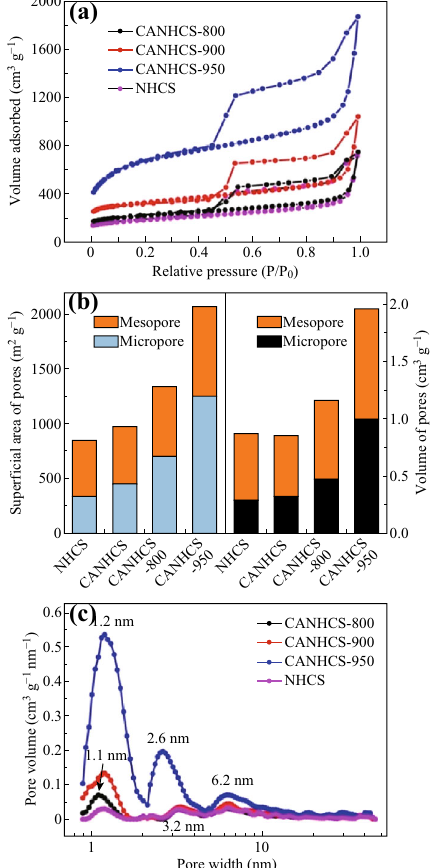
Fig. 5 a N 2 adsorption–desorption isotherms, b the superficial areas and pore volumes in the range of micropore and mesopore, c pore distribution curves of NHCSs, CANHCS-800, CANHCS-900, and CANHCS-950